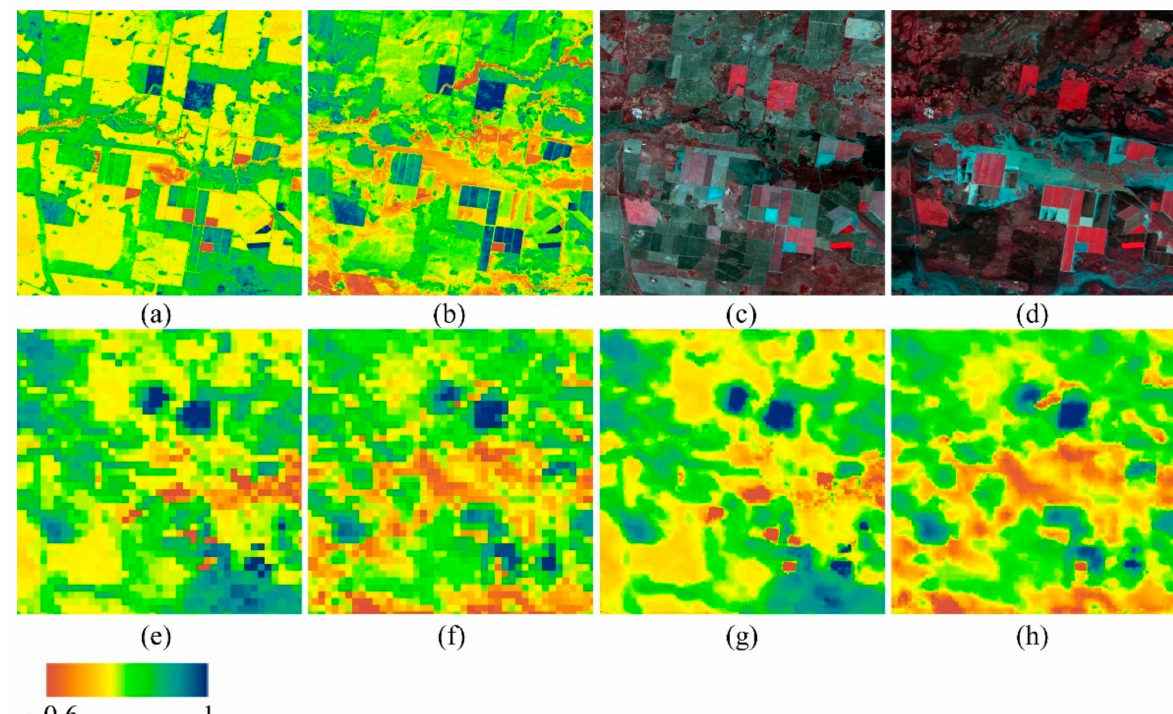
Figure 5. Test data for the Gwydir area: Landsat NDVI obtained on ( a ) 26 November 2004 and ( b ) 12 December 2004, Landsat false-color composite images obtained on ( c ) 26 November 2004 and ( d ) 12 December 2004, ( e , f ) resampled MODIS NDVI for the same dates, and ( g , h ) corrected MODIS NDVI for the same